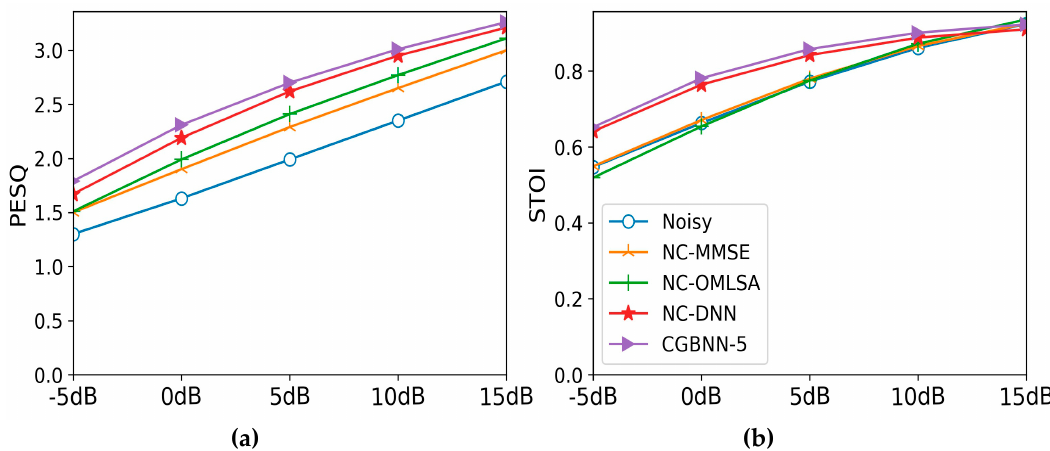
Figure 3. Averaged PESQ and STOI results for environment-aware methods with four known (babble, factory1, destroyer engine, and destroyer operation) noise interferences in a specific application scenario. ( a ) Averaged PESQ results; ( b ) Averaged STOI results. .